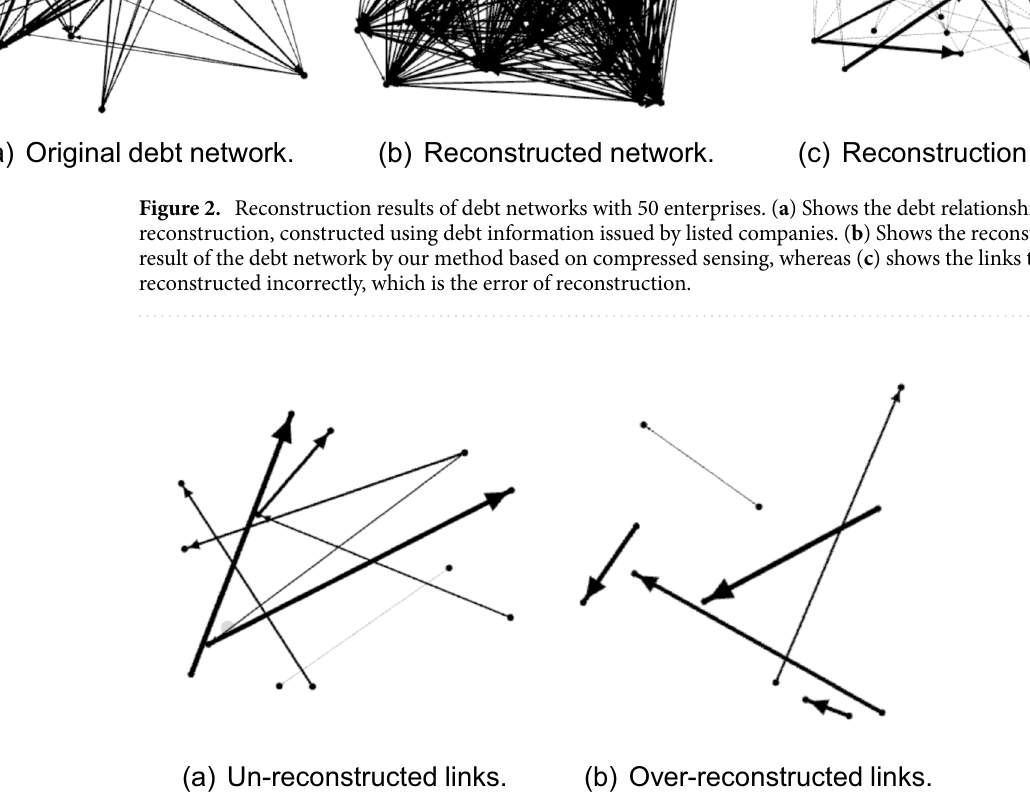
Figure 3. The error between the reconstructed and real network links. ( a ) shows links that are not reconstructed in the real debt network, whereas ( b ) shows the reconstructed links that do not exist in the real debt network.